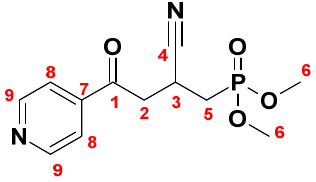
Figure 7. The structure of compound 5g .